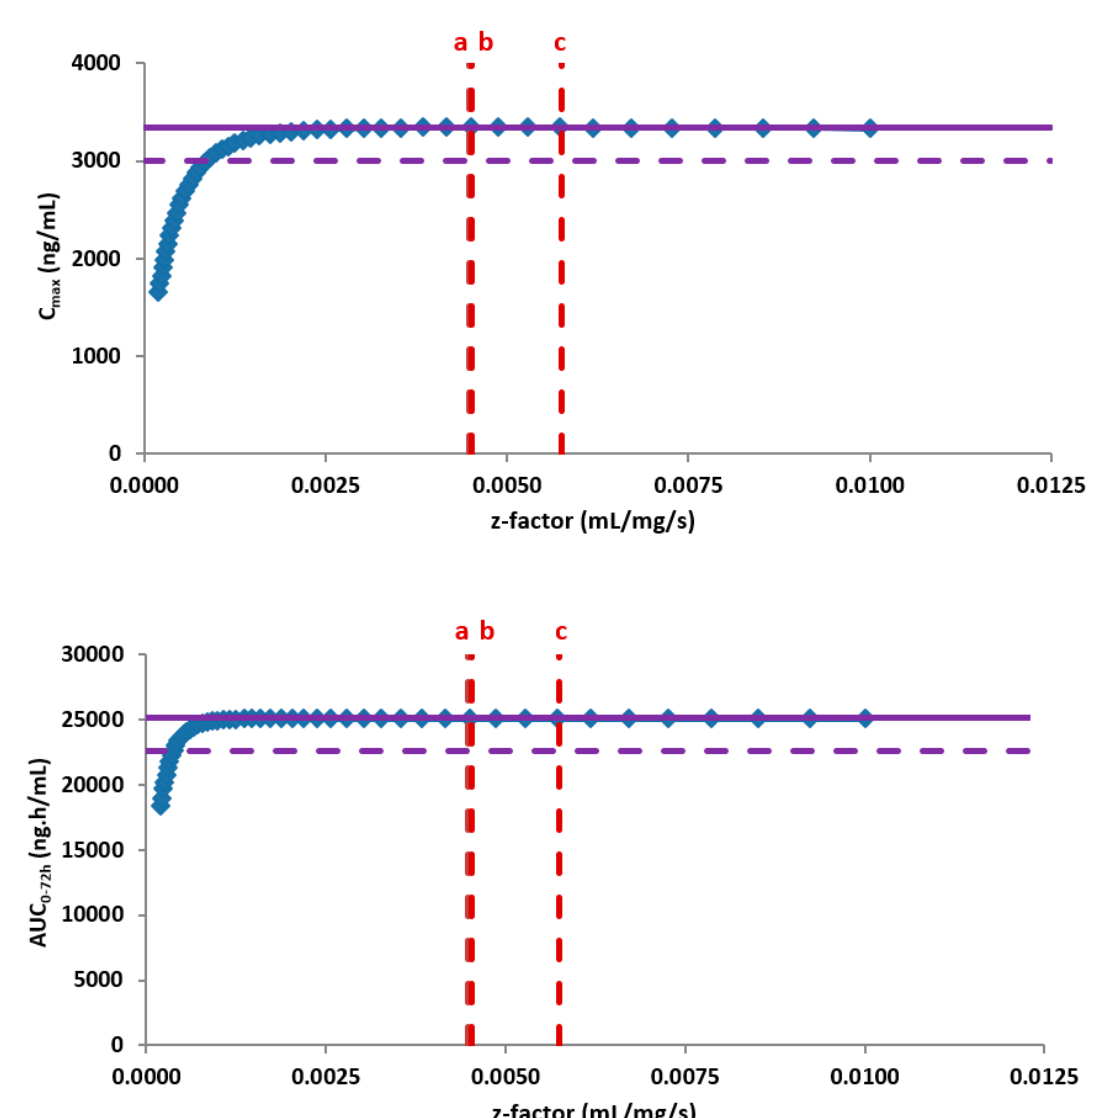
Figure 5. Z-factor parameter sensitivity analysis demonstrating the insensitivity of the PK parameters in fasted conditions to the dissolution rate of the available Active Pharmaceutical Ingredient (API) batches from the new crystal form. The purple solid line represents the clinical exposure of JNJ-1 (reference data), the purple dotted line corresponds to a 10% difference in exposure, the blue dots represent the outcome of the z-factor parameter sensitivity analysis and the red dotted lines correspond to the z-factor calculated from the available API batches of the new crystal form.